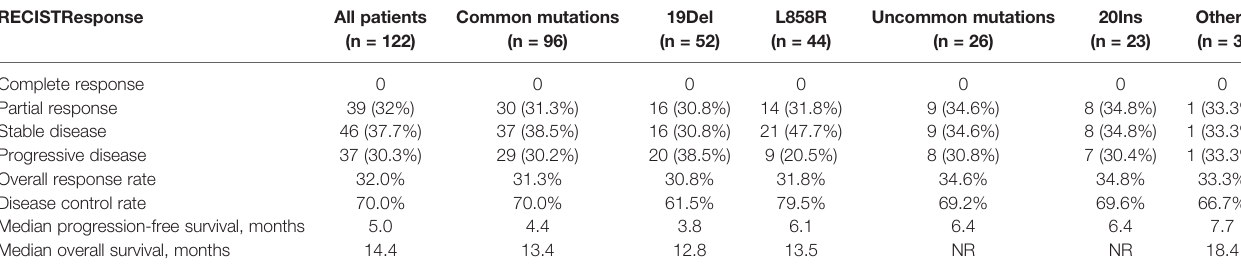
Common mutations (n = 122) (n = 96)